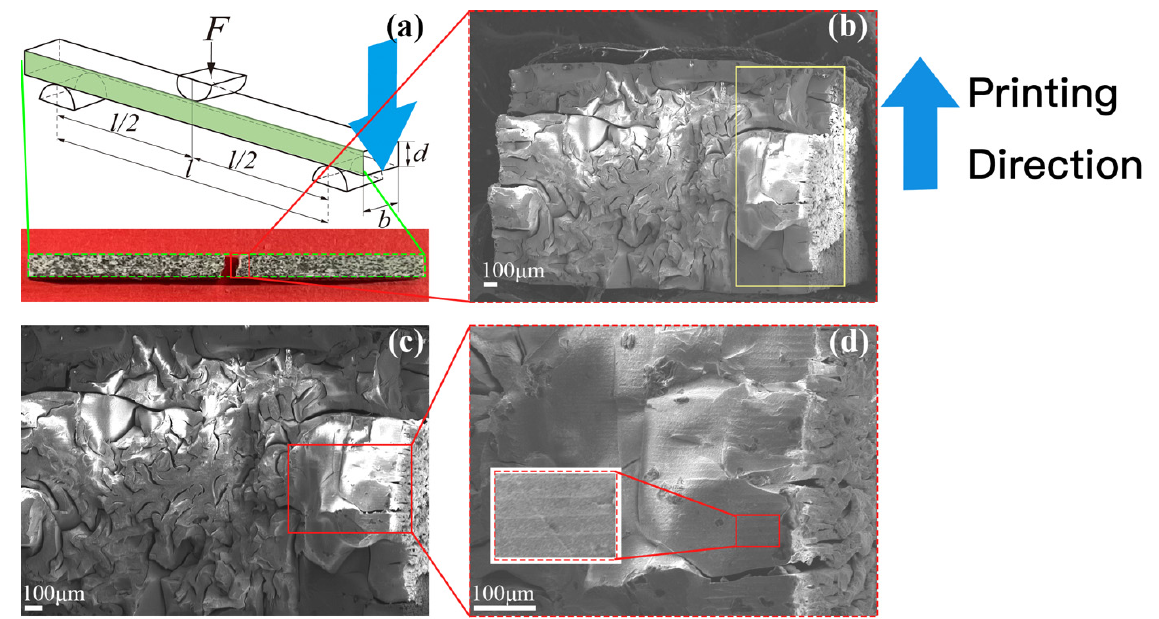
Figure 11. The SEM images of three-point parallel loading. ( a ): Schematic diagram of the experiment; ( b – d ): Fracture morphology and its partial enlarged views.